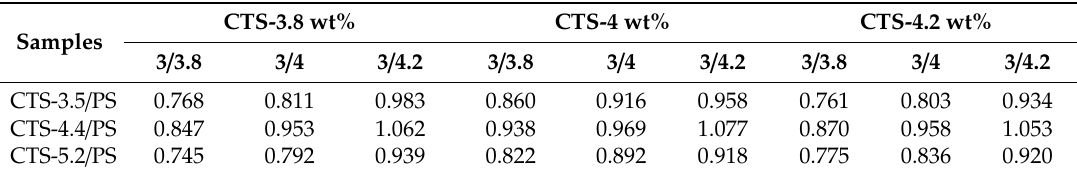
Table 5. Compressive strength of starch-based foams.